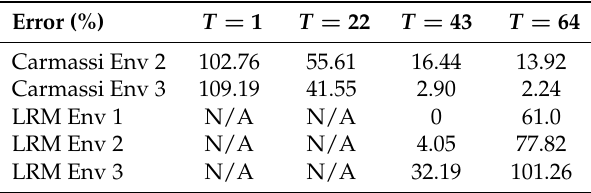
Figure 3. Prediction of the LAI with prediction length q = 1 for MicroTom with sparse data in three environments: Env 1 (warm and bright), Env 2 (shaded and emergency heating), and Env 3 (indoor and artificial illumination). Table 3. Prediction error of the Carmassi and the Linear Regression Model (LRM) for LAI vs. GDT. The parameters of the former were adjusted during the cultivation cycle in Env 1, while the slope and intercept of the latter during the first two measurement points in each cultivation